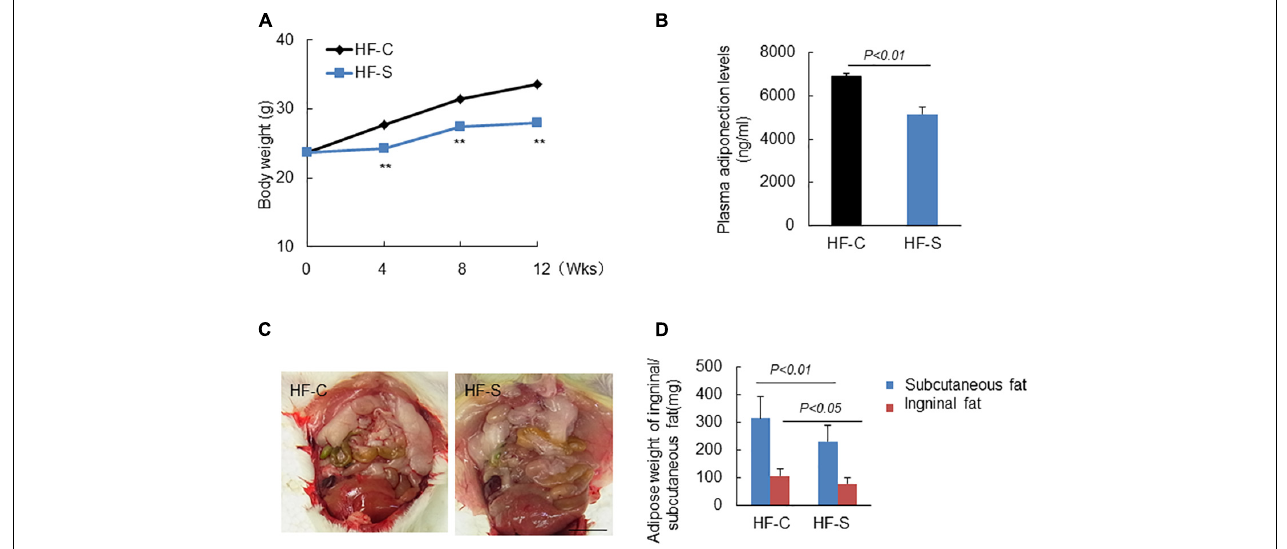
FIGURE 1 | Body weight (BW), adipose weight and adiponectin levels in the two experimental groups during the experimental period. (A) Chronic stress reduced BW in a time dependent manner. (B) Chronic stress decreased serum APN levels. (C,D) Representative images show the inguinal fat, and chronic stress reduced the weight of subcutaneous and inguinal fat. Data are presented as means ± SEM ( n = 6–8). P < 0.05 was considered statistically significant by Student’s un-paired t -test. Scale bars: 200 µ m (D).